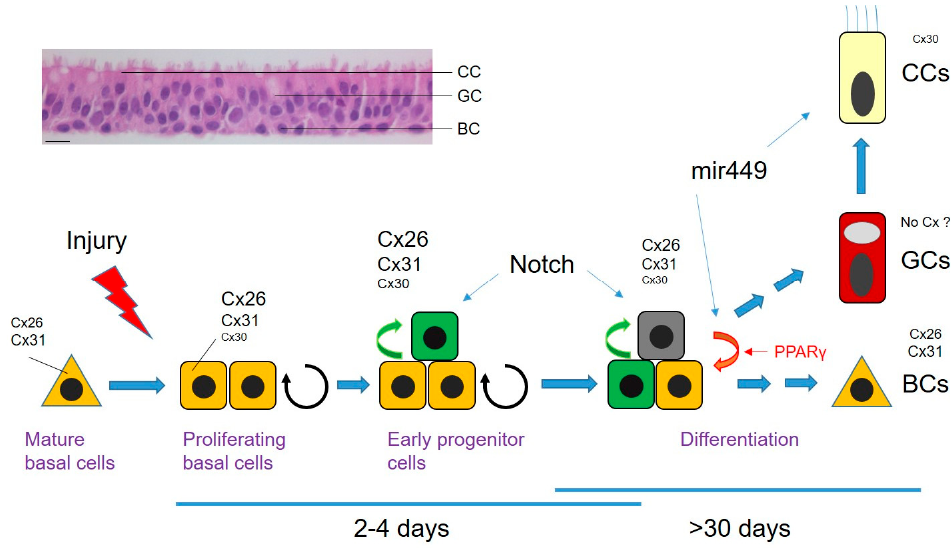
Figure 1. The different phases of airway epithelium regeneration after wounding. The top left images show the histology of the pseudostratified airway epithelium after culturing human airway epithelial cells for 1.5 months on Transwell filter, and the capacity of the epithelium to repair after wounding. BC: basal cell; CC: ciliated cell; GC: goblet cell. The scheme illustrates the steps involved in airway epithelium repair after injury (blue arrows); wound closure is reached within 3–4 days. Orange triangle: CK5-expressing quiescent basal cells; orange square: CK5 and CK14-activated basal cells; light green square: early progenitor cells; dark green square: late progenitor cells. Early differentiation (passage from proliferating cells to early progenitors) is dictated in part by Notch activation (green arrows). Cell division arrest and later differentiation requires increased expression of miR-449. The relative changes in connexin expression (Cx26, Cx30, Cx31) is illustrated for the different stages of the repair process by the size of the fonts. PPAR γ signalling also contributes to BC differentiation and decreases connexin expression (red arrow). Bar: 50 µm.